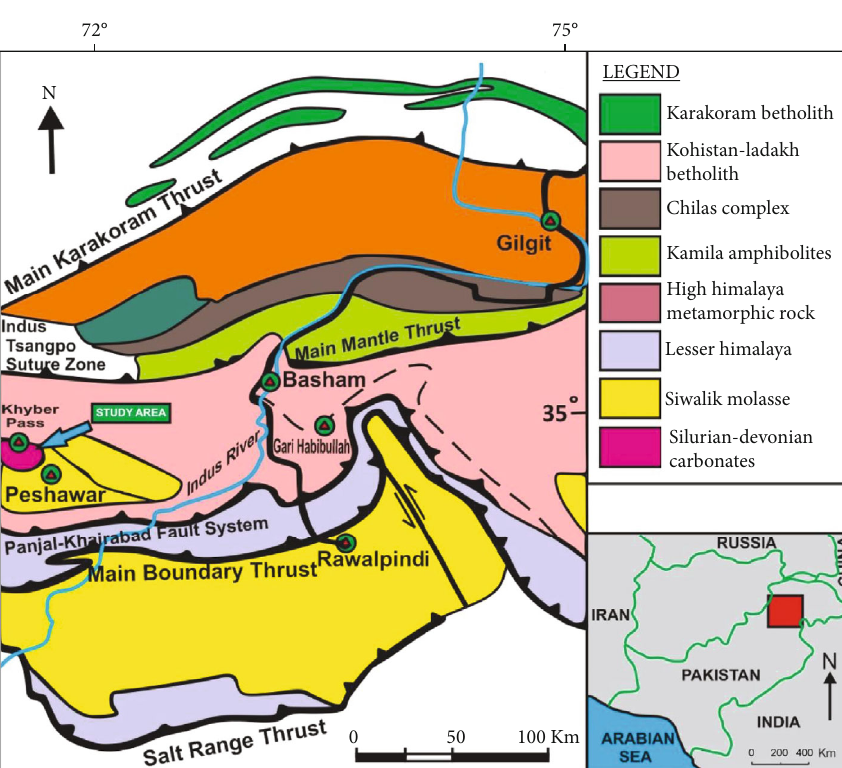
Figure 1: Regional map of tectonostratigraphic units in the northern Himalaya showing the major structural elements and regional-scale thrust faults together with igneous, metamorphic, and sedimentary domains (modi fi ed from [53]). The study area NW of Peshawar in northern Pakistan is